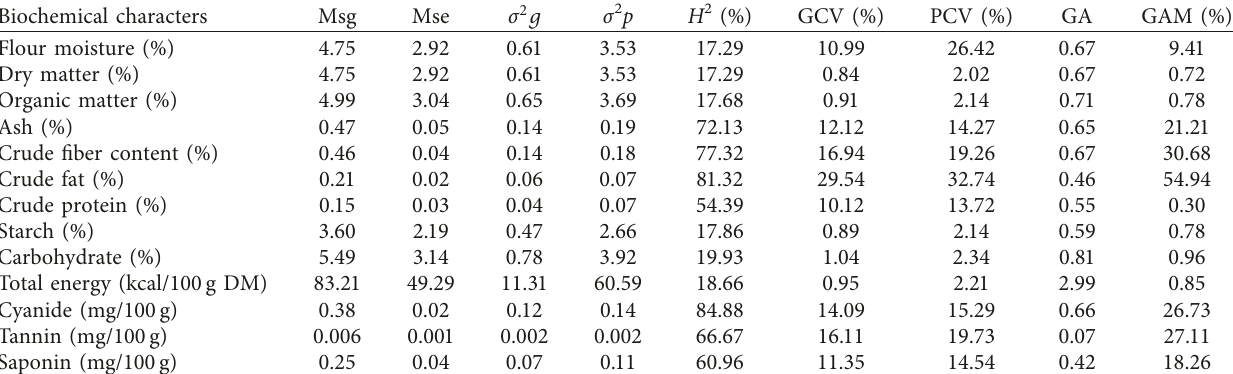
Table 4: Variances, heritability, coefficient of variation, and genetic advance of 13 characters of 64 cassava accessions. Biochemical